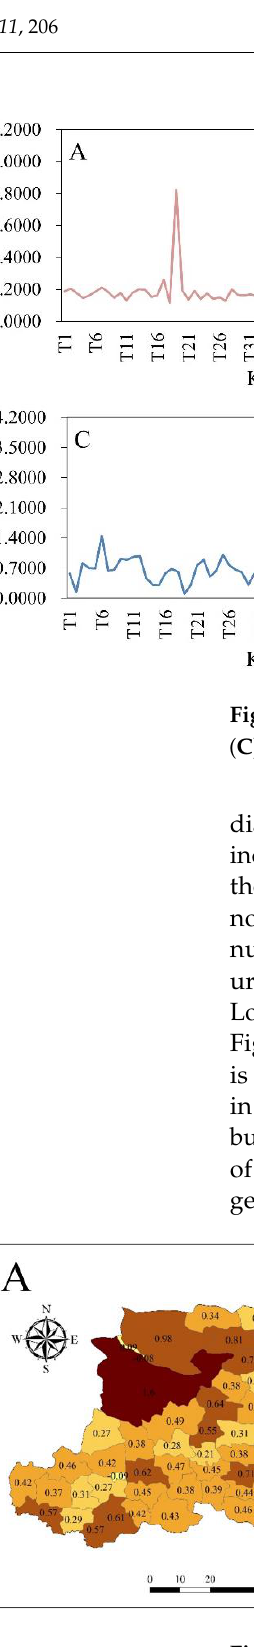
Figure 8. Comprehensive value of the ventilation potential in Kaifeng ( A ) and the line chart ( B ).